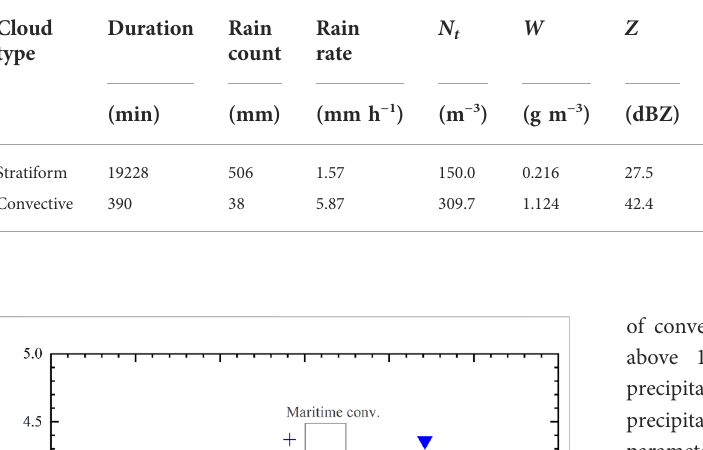
Table 3. The total concentration of raindrops N t (m − 3 ), liquid